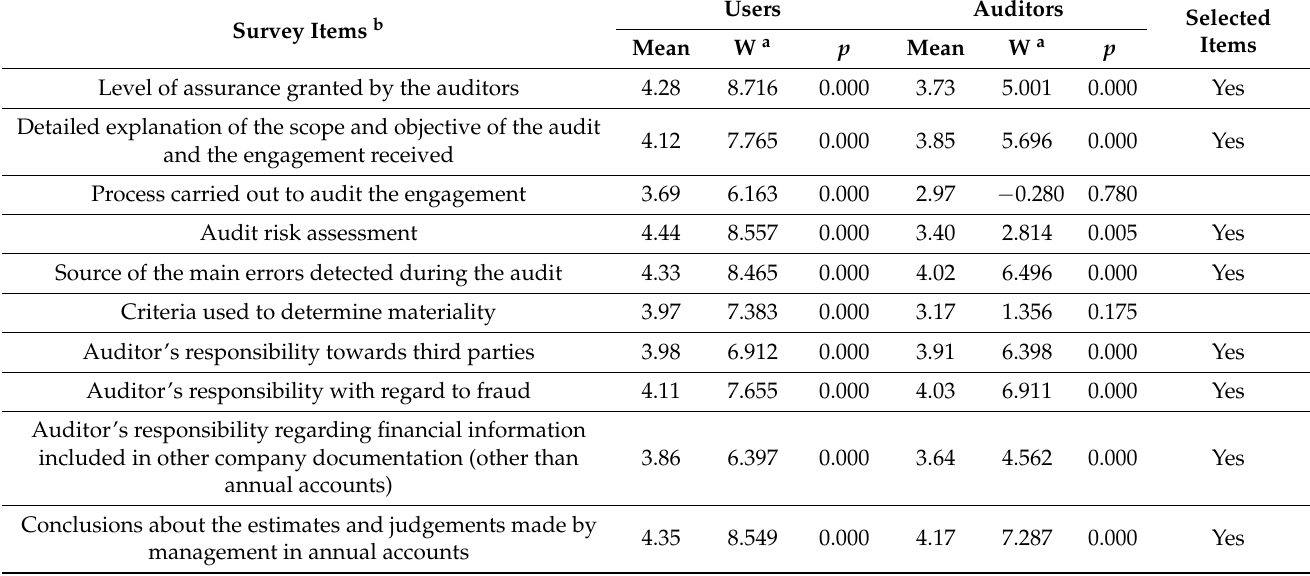
Table 5. Perceptions of the content of audit reports to enhance their